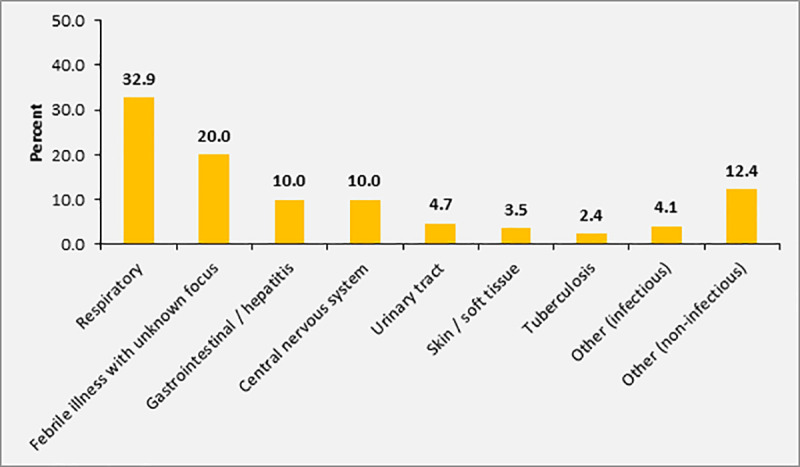
Sources of infection / main diagnosis in patients with SOFA score ≥2 (n = 170).